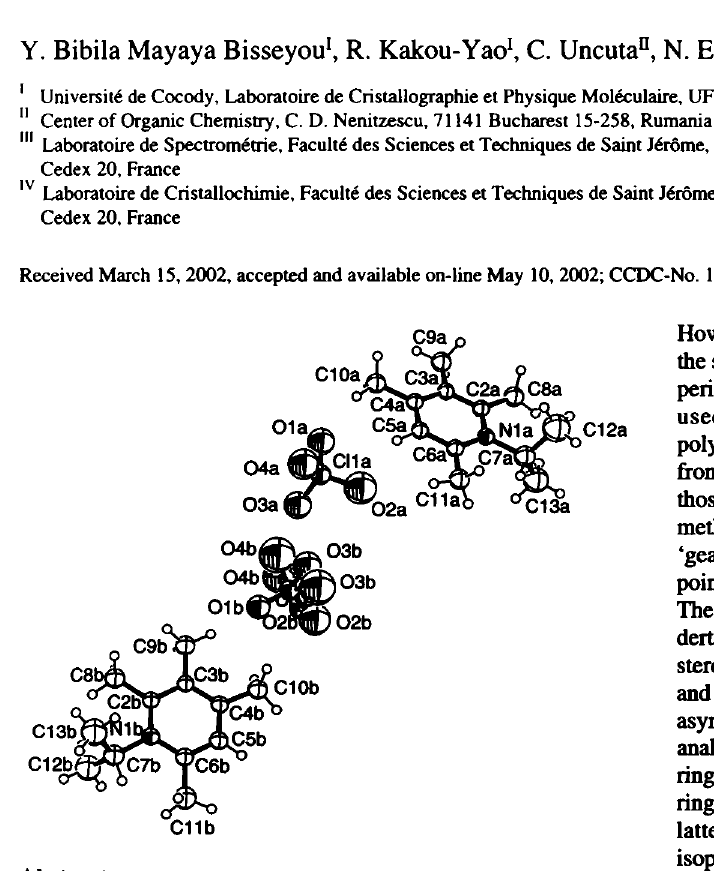
Table 1. Data collection and handling.